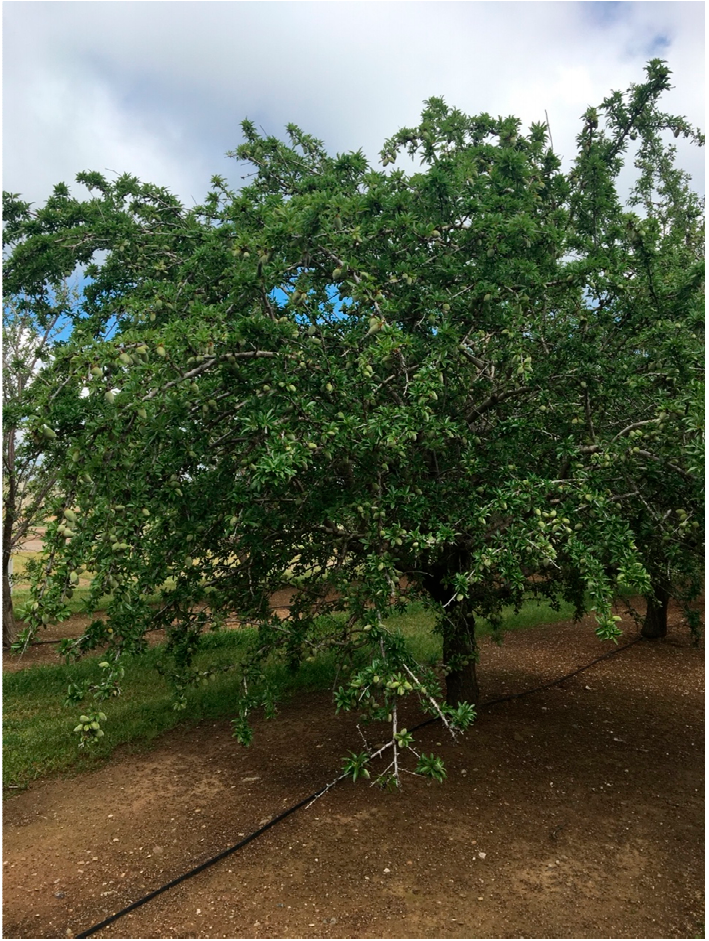
Figure 1. Image of almond cultivar Nonpareil (photo taken by K. D’Amico-Willman in May 2018). Almond exhibits an age-related disorder known as non-infectious bud-failure (BF) affecting vegetative bud development in the spring [8,10]. Genotypes exhibiting this disorder show characteristic dieback at the top of the canopy, and severe levels of BF can result in up to 50% yield loss [11]. Empirical evidence shows BF is associated with age [12]; however, as almonds are produced primarily through vegetative propagation rather than by seed, their true ontogenetic age and thus susceptibility to BF can be difficult to assess [8]. Biomarkers indicative of age would be valuable to growers, breeders, and producers to screen germplasm. Thus, the almond represents a potential model species for the study of aging in perennials due to its economic relevance, the abundance of available germplasm and breeding programs, and the exhibition of an age-related disorder.